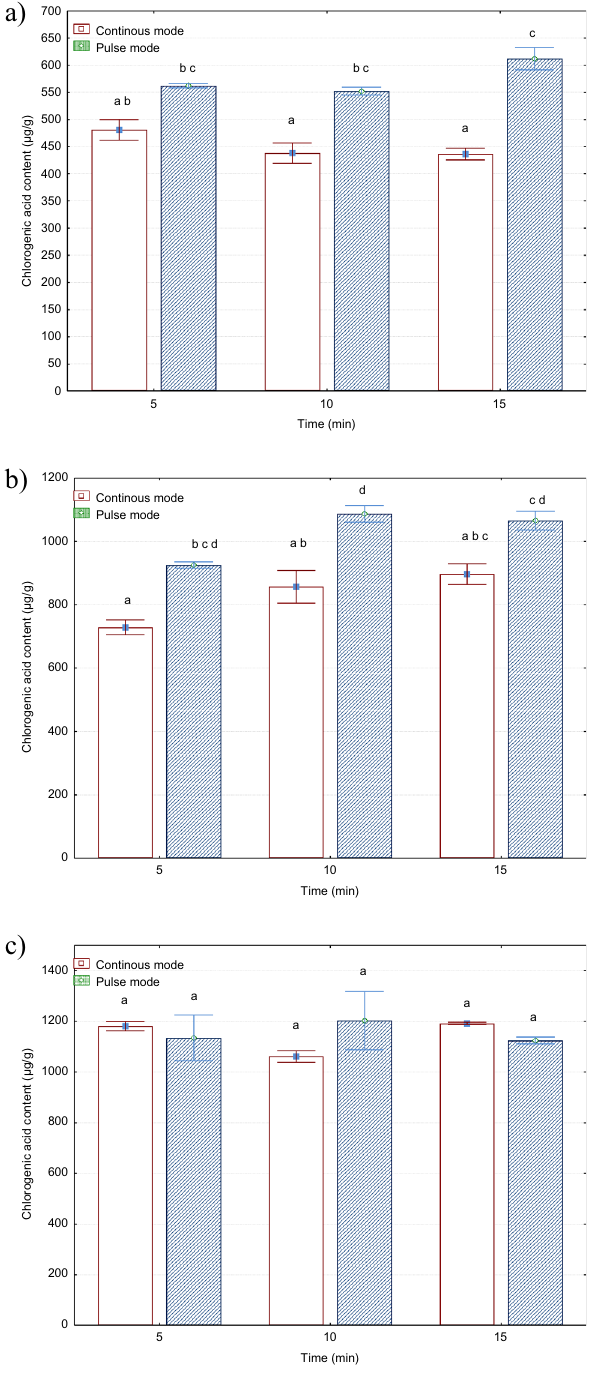
Figure 2. Effect of ultrasonic treatment parameters on the content of chlorogenic acid (µg/g d.m.) in Sorbus intermedia berries extracts: ( a ) amplitude 12 µm, ( b ) amplitude 24 µm, ( c ) amplitude 36